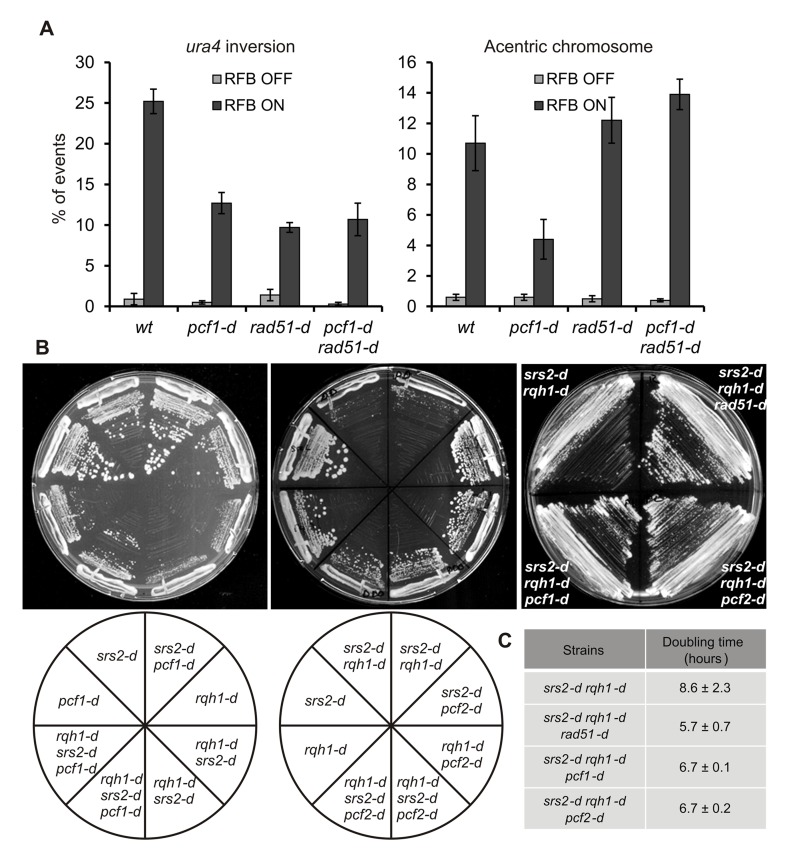
CAF-1 stabilizes Rad51-dependent JMs.(A) Quantification of ura4 inversion and acentric chromosome in indicated strains and conditions (see Figure S2 for details). Values correspond to the mean of at least three independent experiments ±SD. Refer to Data S1, sheet 4. (B) Cell growth of indicated strains on rich media. (C) Table of doubling time from indicated strains in hours. Values are the mean of three independent experiments ±SD.